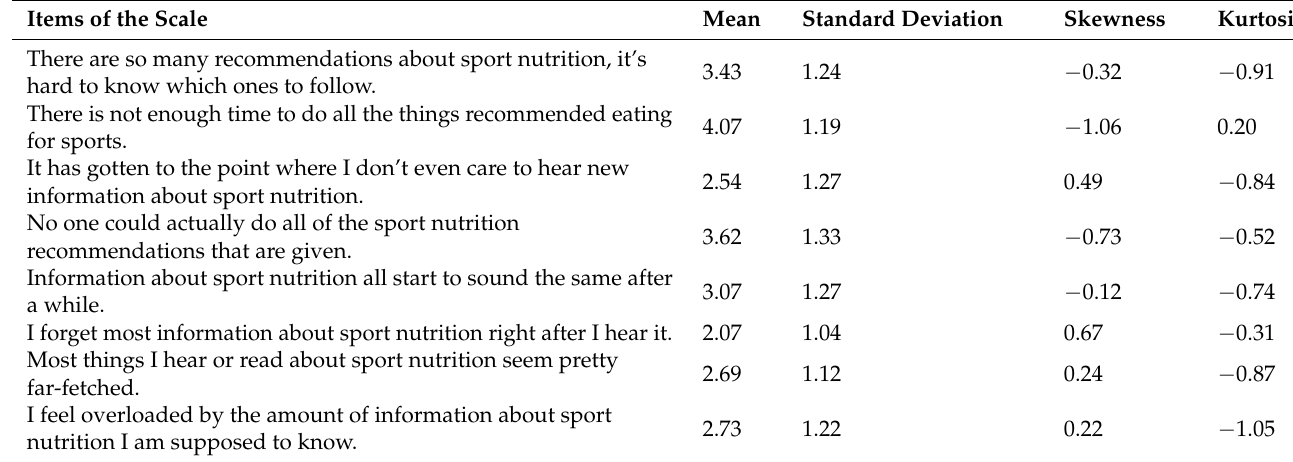
Table 3. Descriptive statistics of responses to different items.